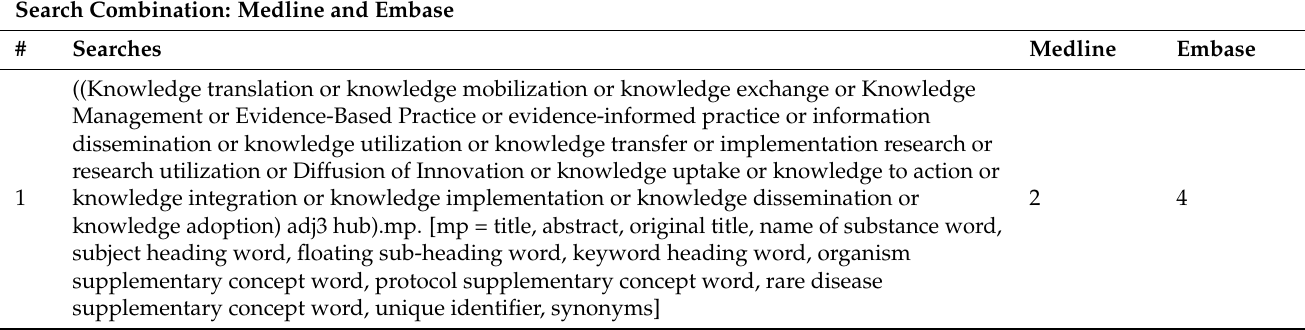
Table A1. Search string and results for Medline and Embase academic database.